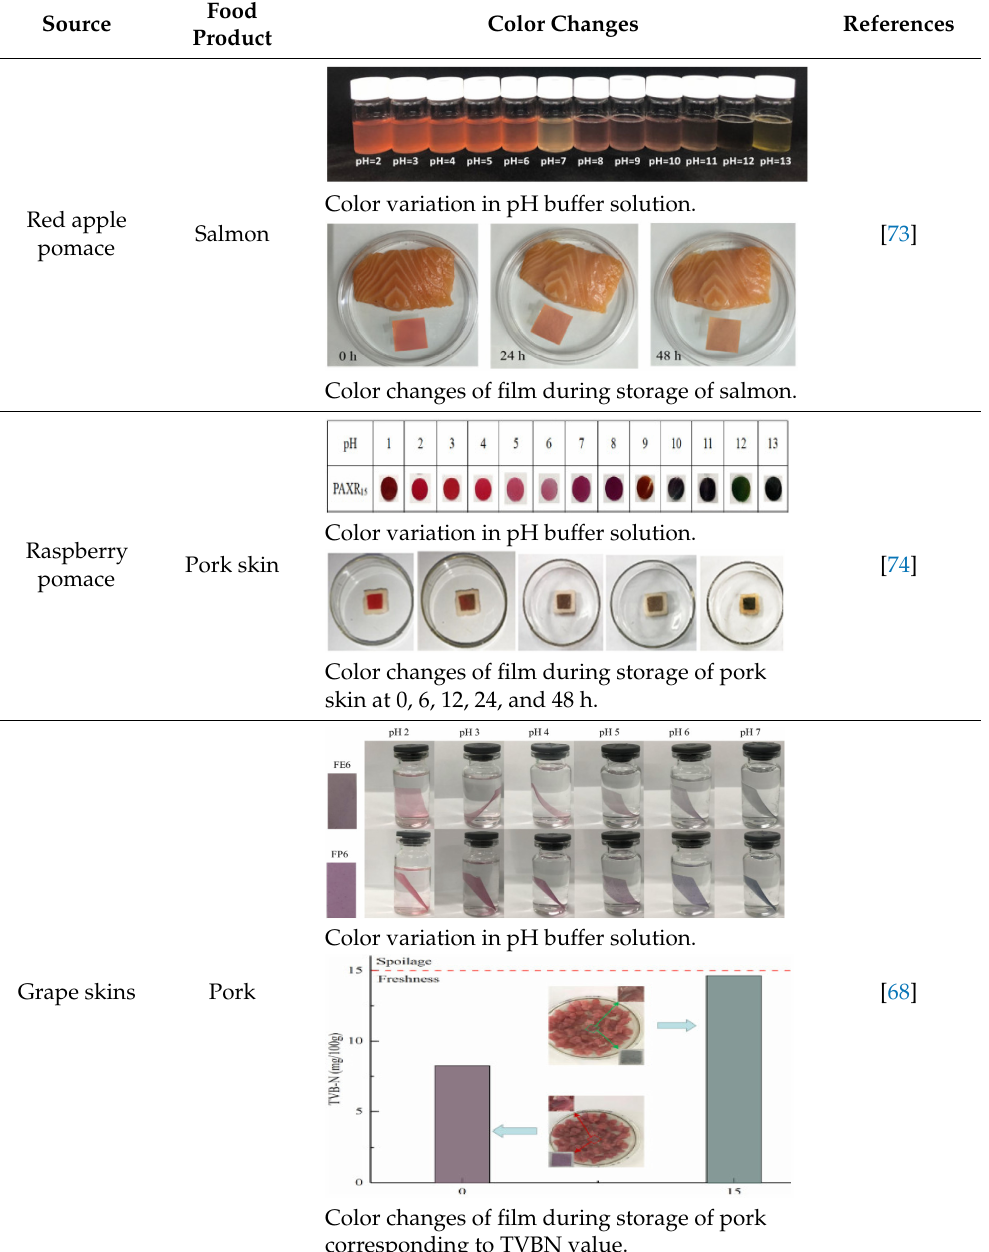
Color changes of film during storage of pork corresponding to TVBN